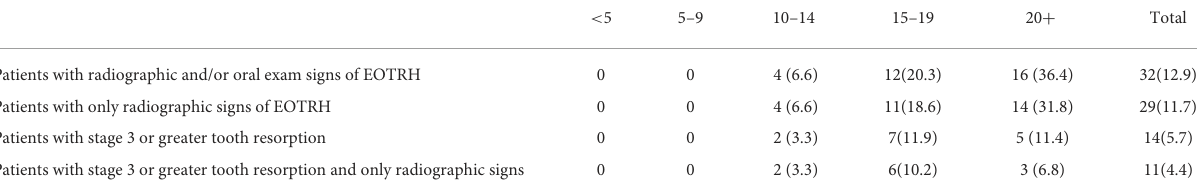
TABLE 6 Equine odontoclastic tooth resorption and